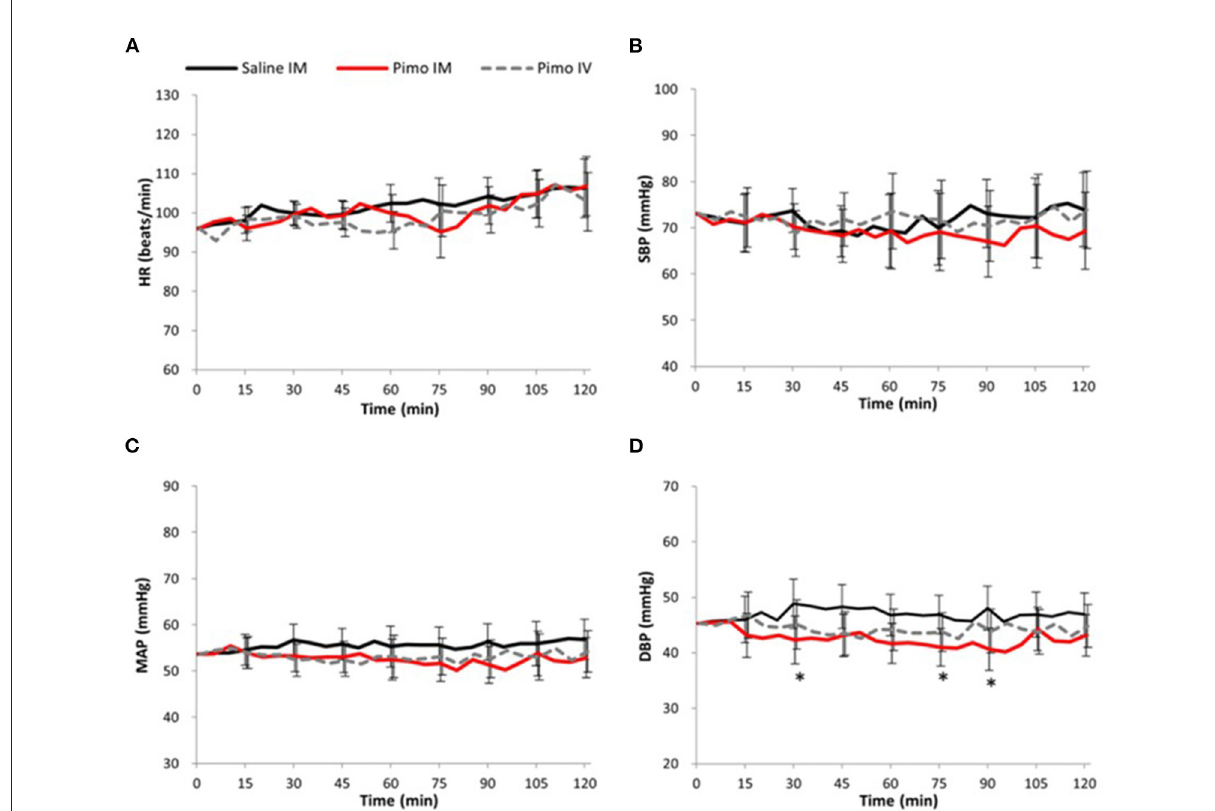
FIGURE1 Data are presented as mean ± 95% confidence interval (error bar). Black line: Saline IM; Red line: Pimobendan IM (Pimo IM); Gray dot line: Pimobendan IV (Pimo IV). (*) fitted to indicate the significance difference between Pimo IM Saline IM, [for the repeated measures ANCOVA (model: time, group, and time*group)]; P < 0.05. (A) Heat rate (HR, beat/min), (B) systolic blood pressure (SBP, mmHg), (C) mean arterial pressure (MAP, mmHg), (D) diastolic blood pressure (DBP,